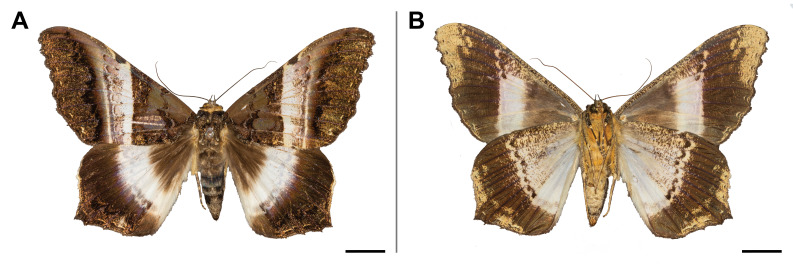
Uripao
albizonata Hampson, 1926. A. dorsal view; B. ventral view. The scale bar represents 1 cm.